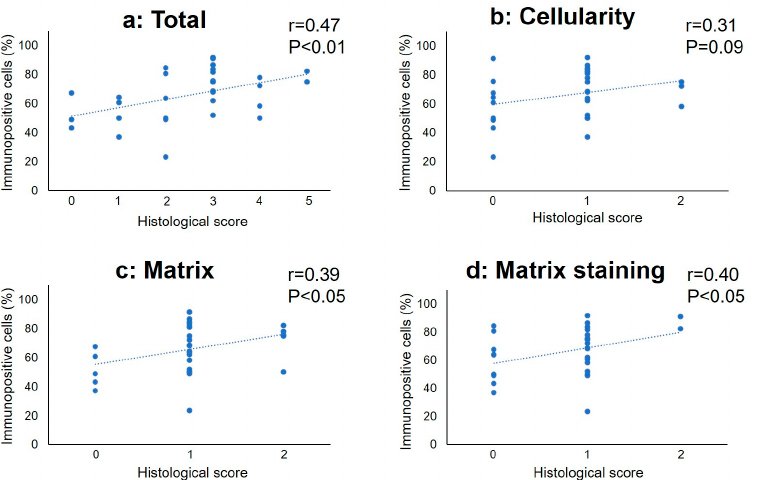
Figure 9. Correlation between the percentage of immunopositive cells for GADD45G and histological score in the total ( a ), cellularity ( b ), matrix ( c ), and ( d ) matrix staining score. r: correlation effi- cient.